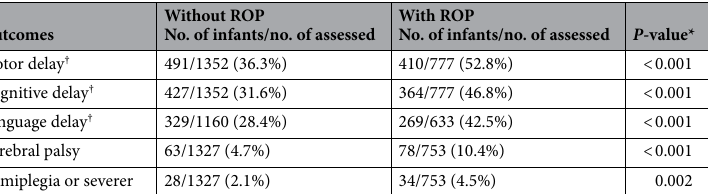
Table 2. Neurodevelopmental outcomes in infants with and without retinopathy of prematurity (ROP) among those with assessed neurodevelopmental outcomes. *Chi-square test or Fisher’s exact test. † Motor delay is represented by a PDI score of < 85 on BSID-II or a motor score of < 85 on BSID-III or < − 1 SD on K-DST scales. Cognitive delay is represented by an MDI score of < 85 on the BSID-II subsets or a cognitive score of < 85 on the BSID-III or < − 1 SD on the K-DST scales. Language delay is represented by a language score of < 85 on the BSID-III or < − 1 SD on the K-DST scales. As the Bayley-III scale may significantly underestimate neurodevelopmental outcomes in those with visual impairment, we have excluded the outcomes obtained by BSID-III in those with the impairment (n = 3).